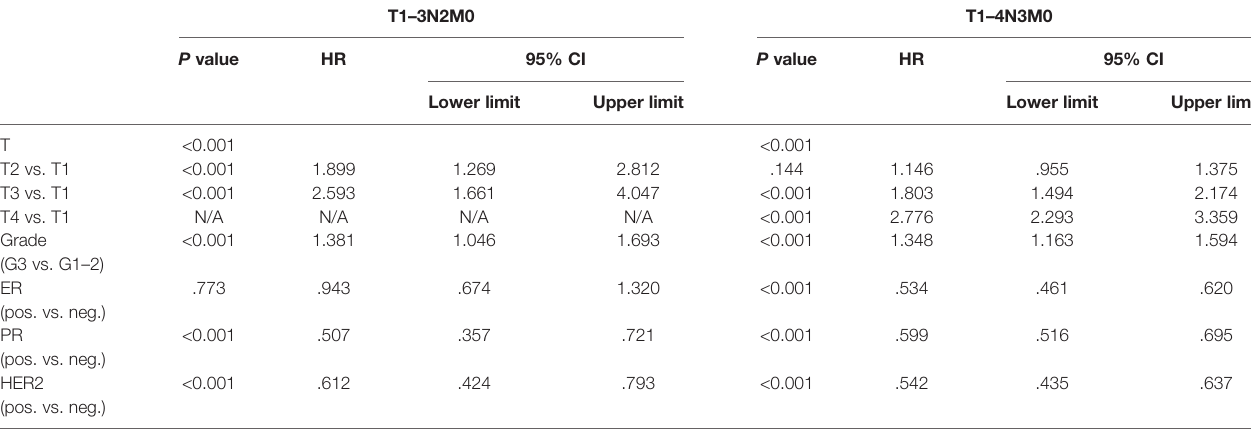
TABLE 3 | Multivariate survival analysis by Cox proportional hazard regression modeling in T1 – 3N2M0 and T1 – 4N3M0 breast cancer